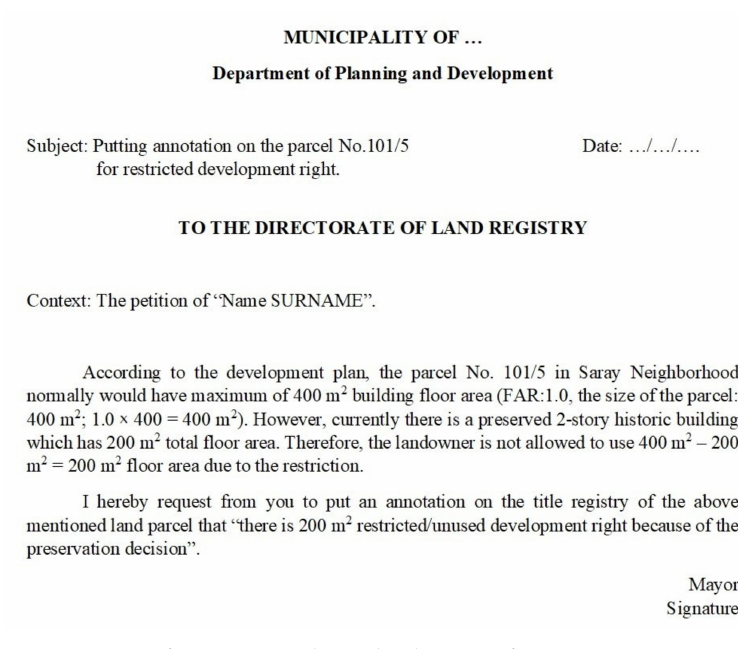
Figure 9. Letter from municipality to land registry for